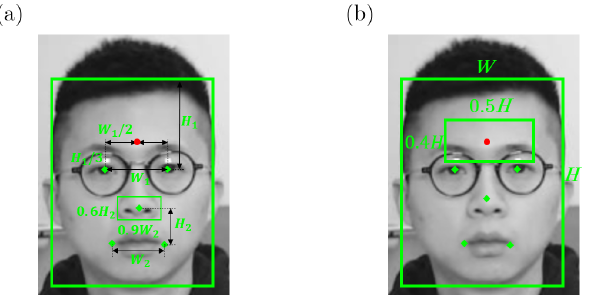
Figure 6. A demonstration of ROIs localization using facial landmarks, ( a ) the definitions of ROI BT and ROI RR , ( b ) the definition of ROI HR